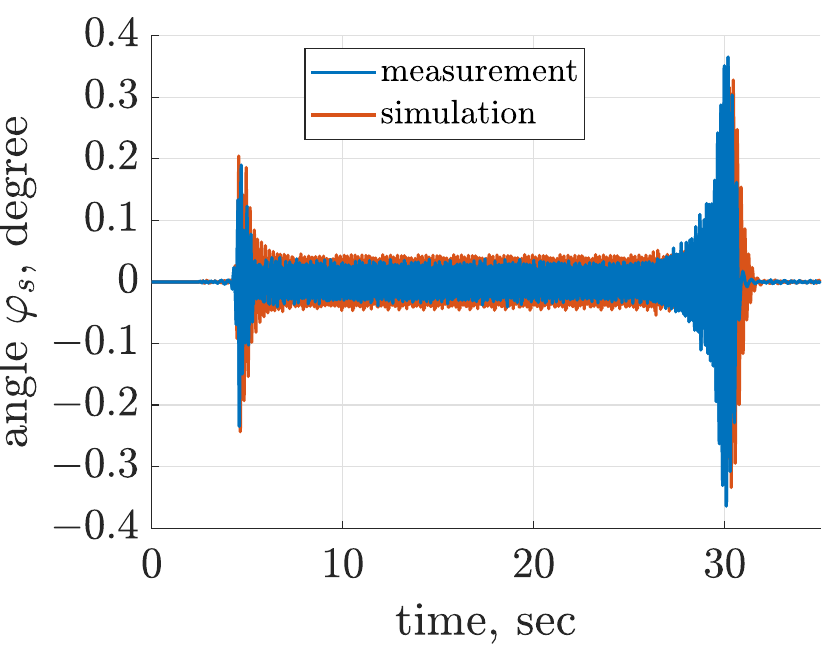
Figure 9. Comparison of time diagrams of riddle angle ϕ s evaluated for measurement and simulation results based on acceleration signals for locations at extreme front and rear measurement points of the vibrating